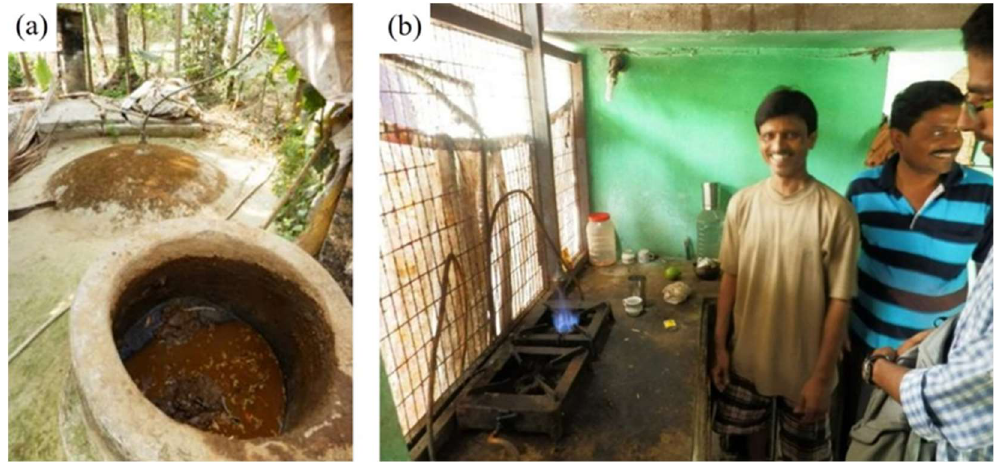
Figure 11. Example of a household bioenergy system: biogas digester ( a ) directly linked with a kitchen ( b ), where the produced biogas can be used for cooking (Image credit: B. Winkler).